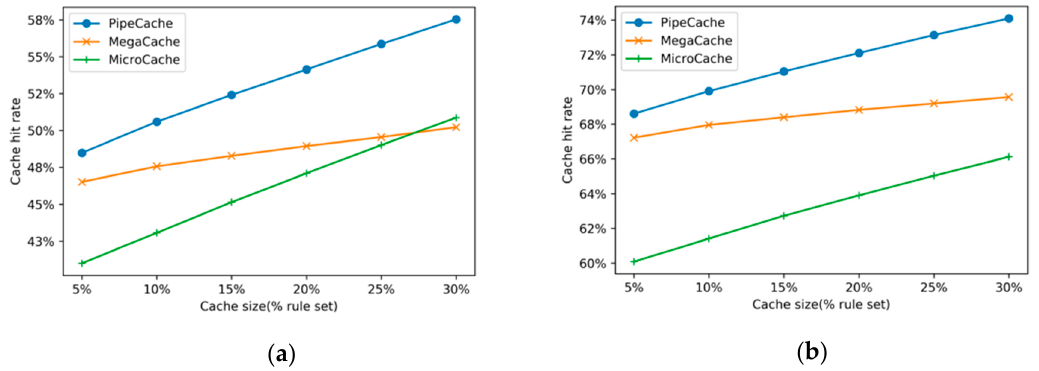
Figure 8. Cache hit rates with different cache sizes. ( a ) b = 0.1. ( b ) b = 0.2.